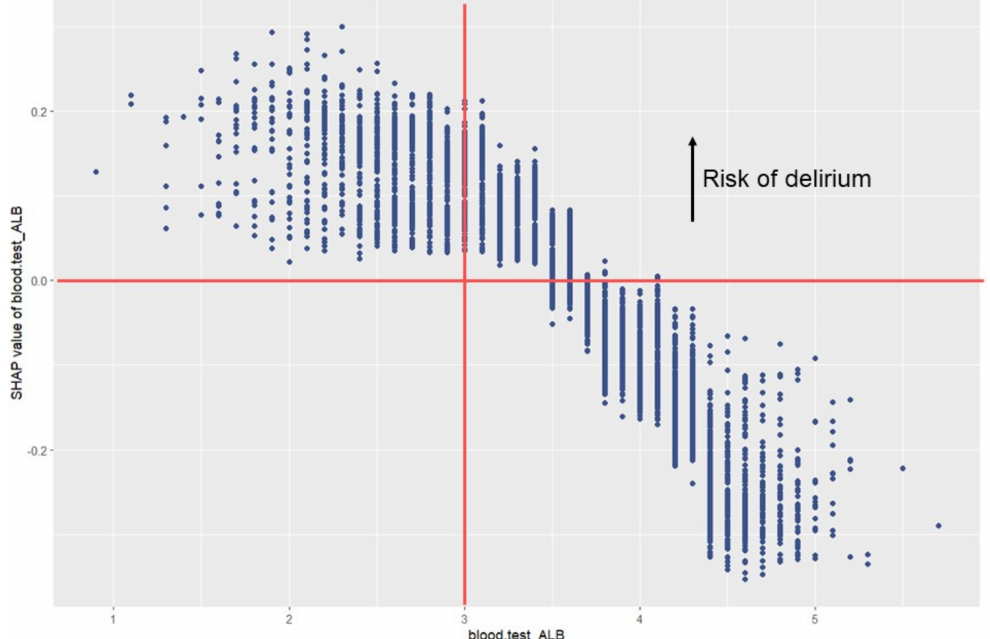
Figure 6. SHAP dependence plot for albumin levels in Population B. Each dot denotes a patient. The x-axis shows the albumin levels, and the y-axis shows the SHAP values attributed to the albumin levels. Higher SHAP values represent higher risk of delirium due to albumin